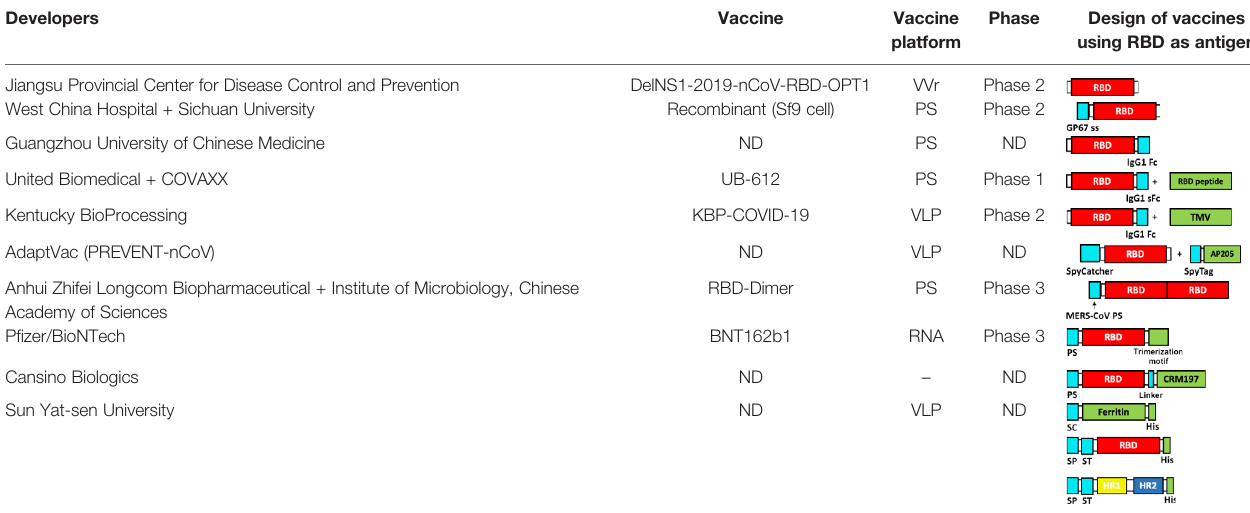
TABLE 2 | Strategies in the design of SARS-CoV-2 vaccines that use RBD of the S glycoprotein.